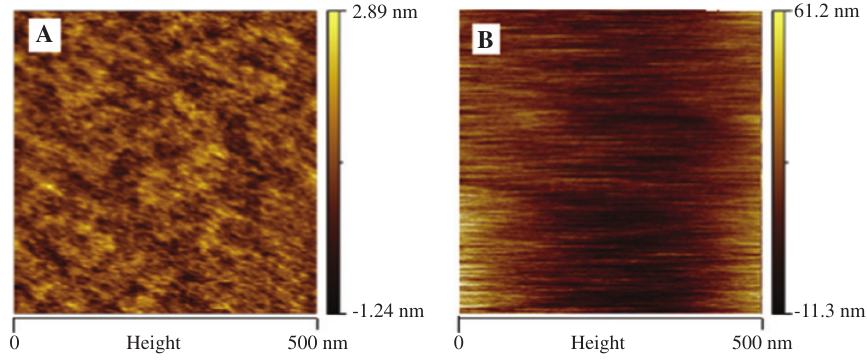
Figure 10: AFM two-dimensional images of (A) pure PVA and (B) doped PVA.